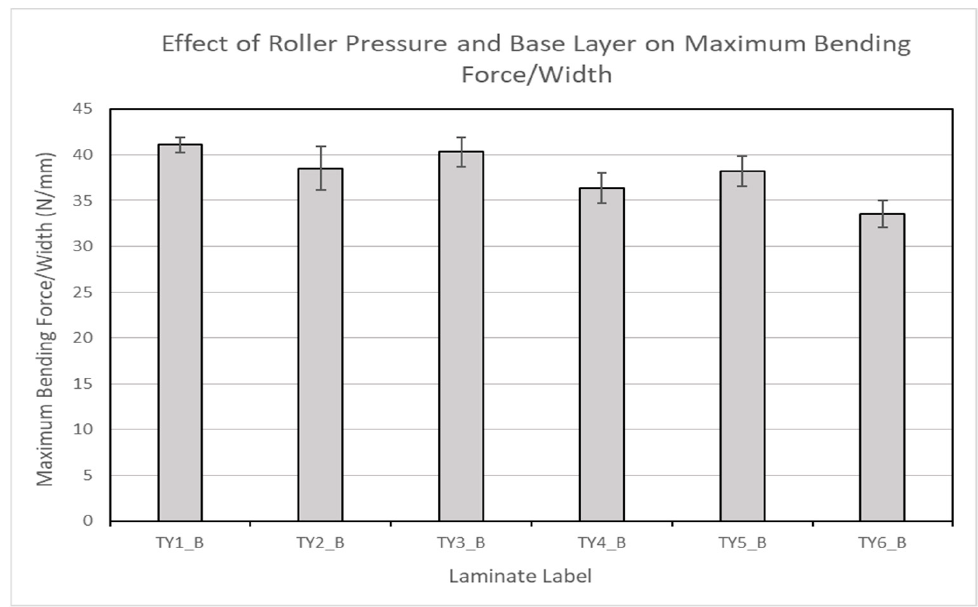
Figure 19. Effect of roller pressure and base layer on maximum bending force/width for all laminates.